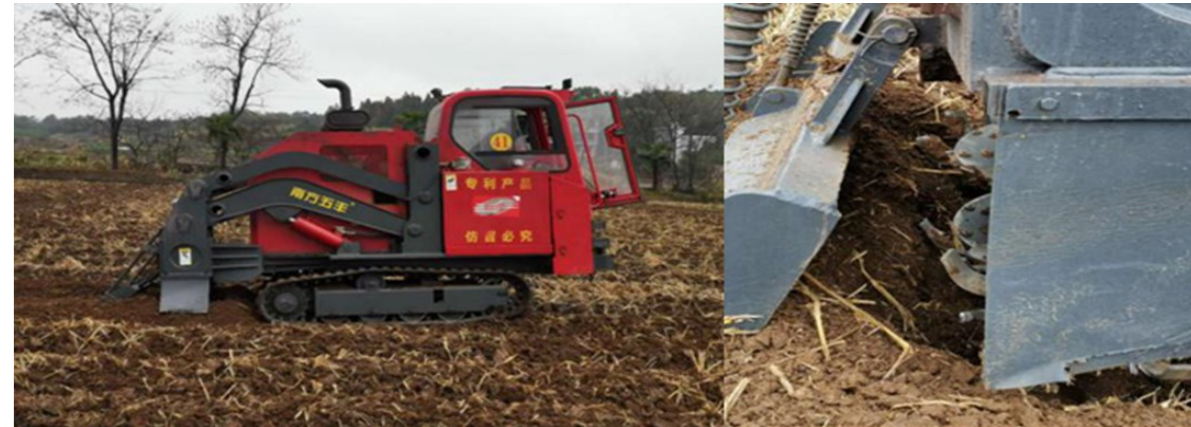
Figure 1. The smash ridge tillage machine.